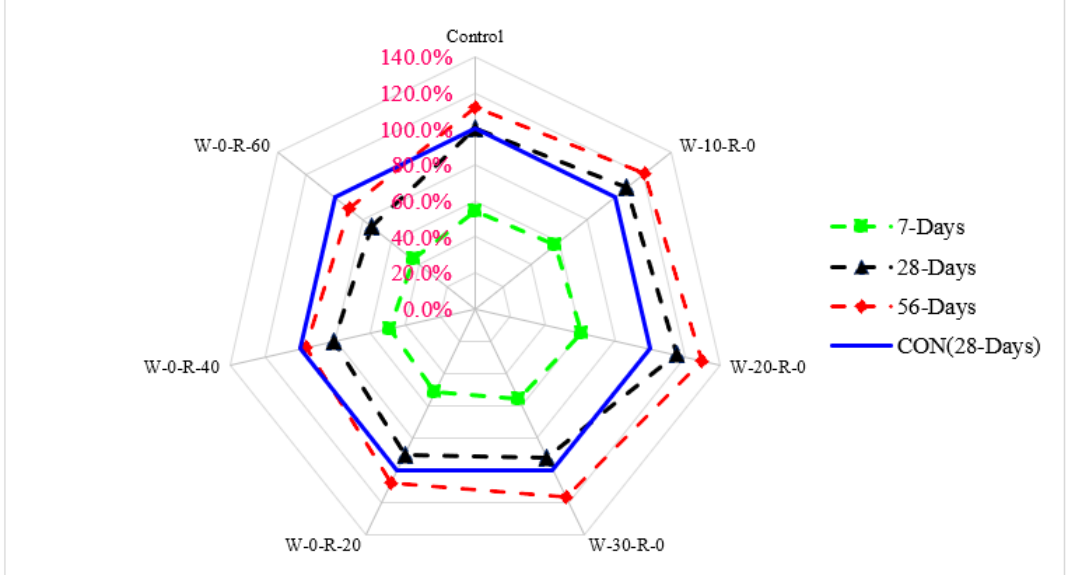
Figure 17. Relative punching strength.